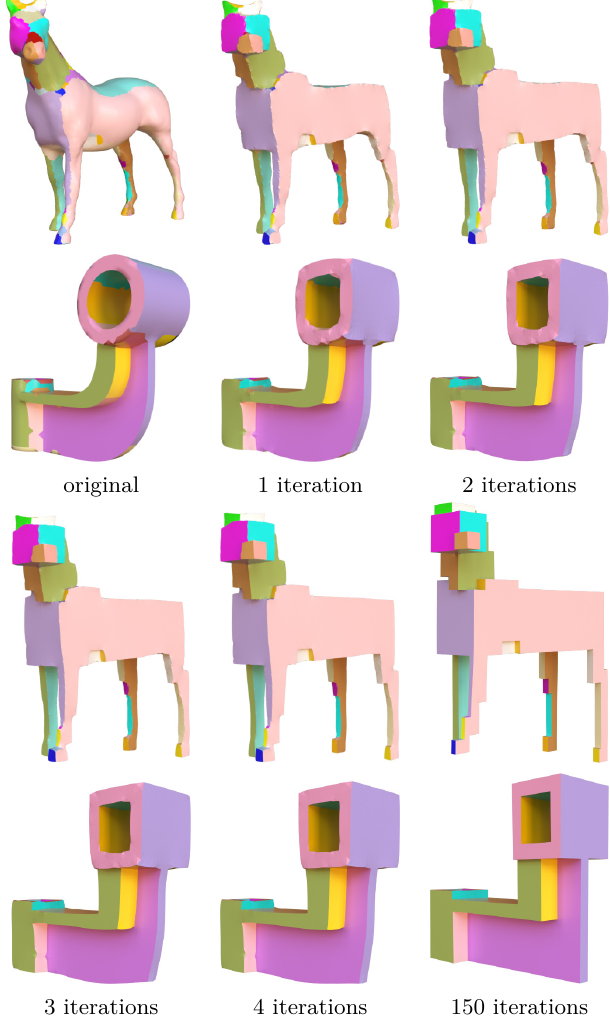
Fig. 4 Iterations of polycube deformation for two